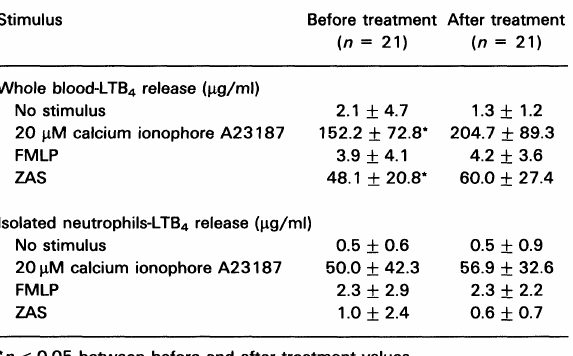
*p < 0.05 between before and after treatment